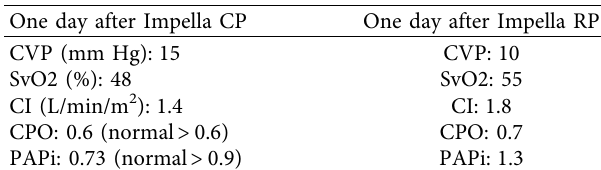
Table 1: Hemodynamic parameters before and after biventricular impella support.